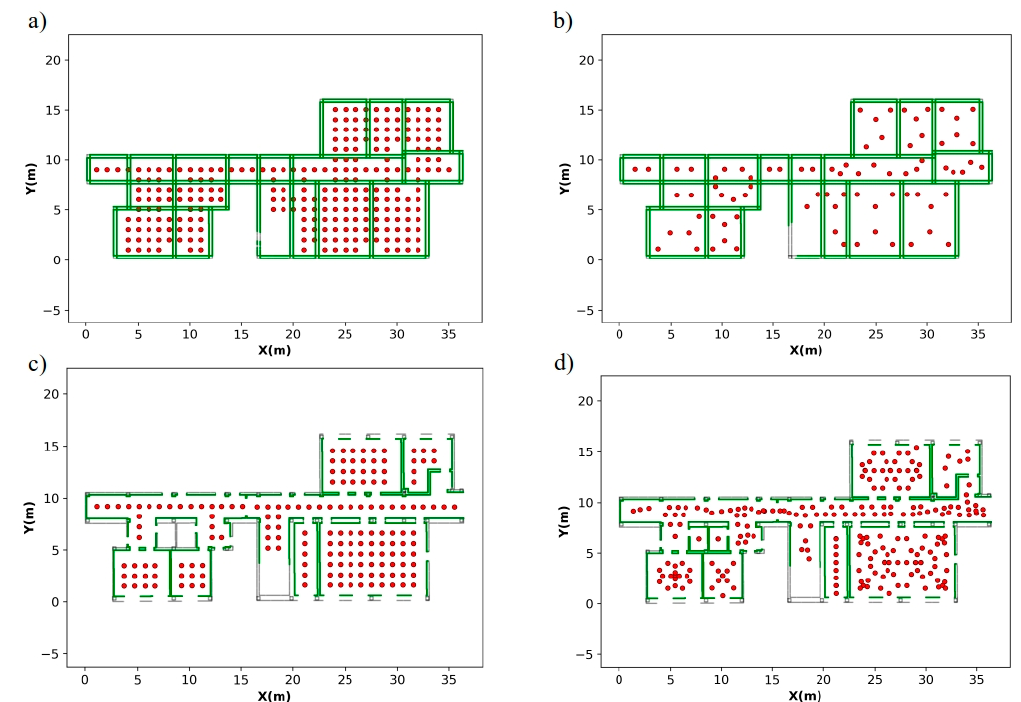
Figure 16. Visibility analysis results obtained from candidates generated in case study 1: ( a ) grid-based candidate distribution in structural phase, ( b ) triangulation-based candidate distribution in structural phase, ( c ) grid-based candidate distribution with rooms and ( d ) triangulation-based candidate distribution with rooms. Elements determined as visible for analysis process are depicted in green, black points represent no visible elements.